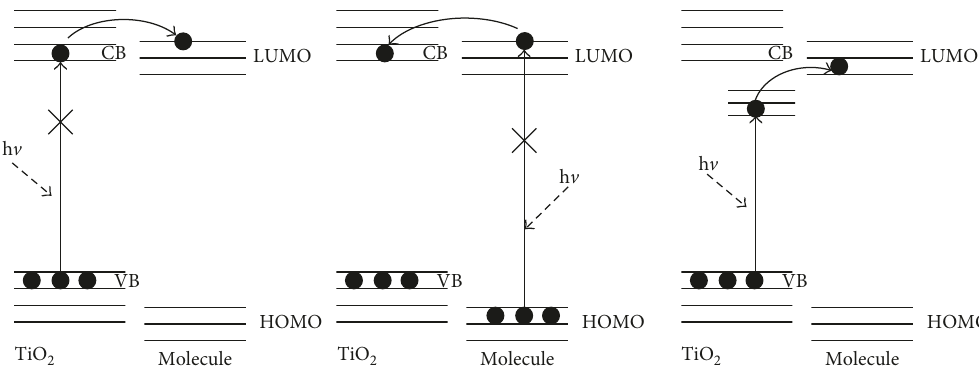
Figure 5: Charge transfer mechanism model between absorbed molecule and TiO et al. [17].